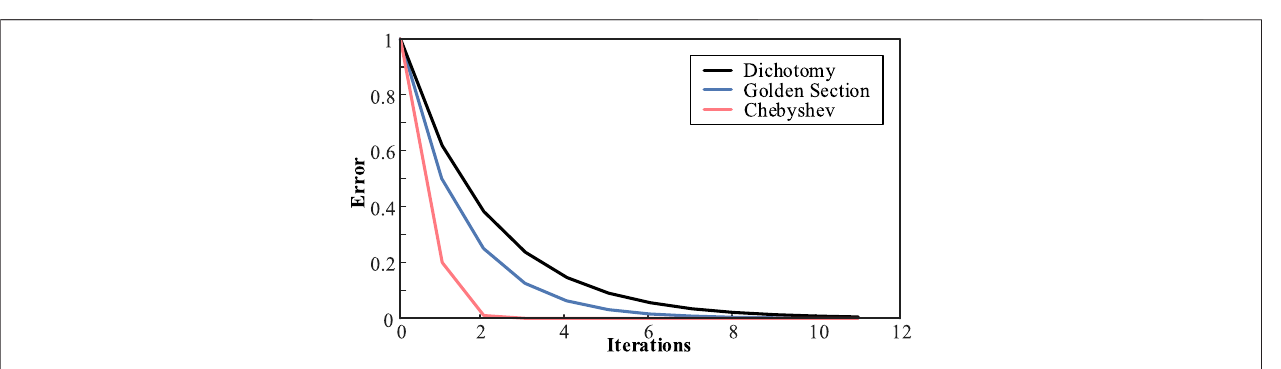
FIGURE 4 | Comparison chart of the relationship between error and number of iterations.